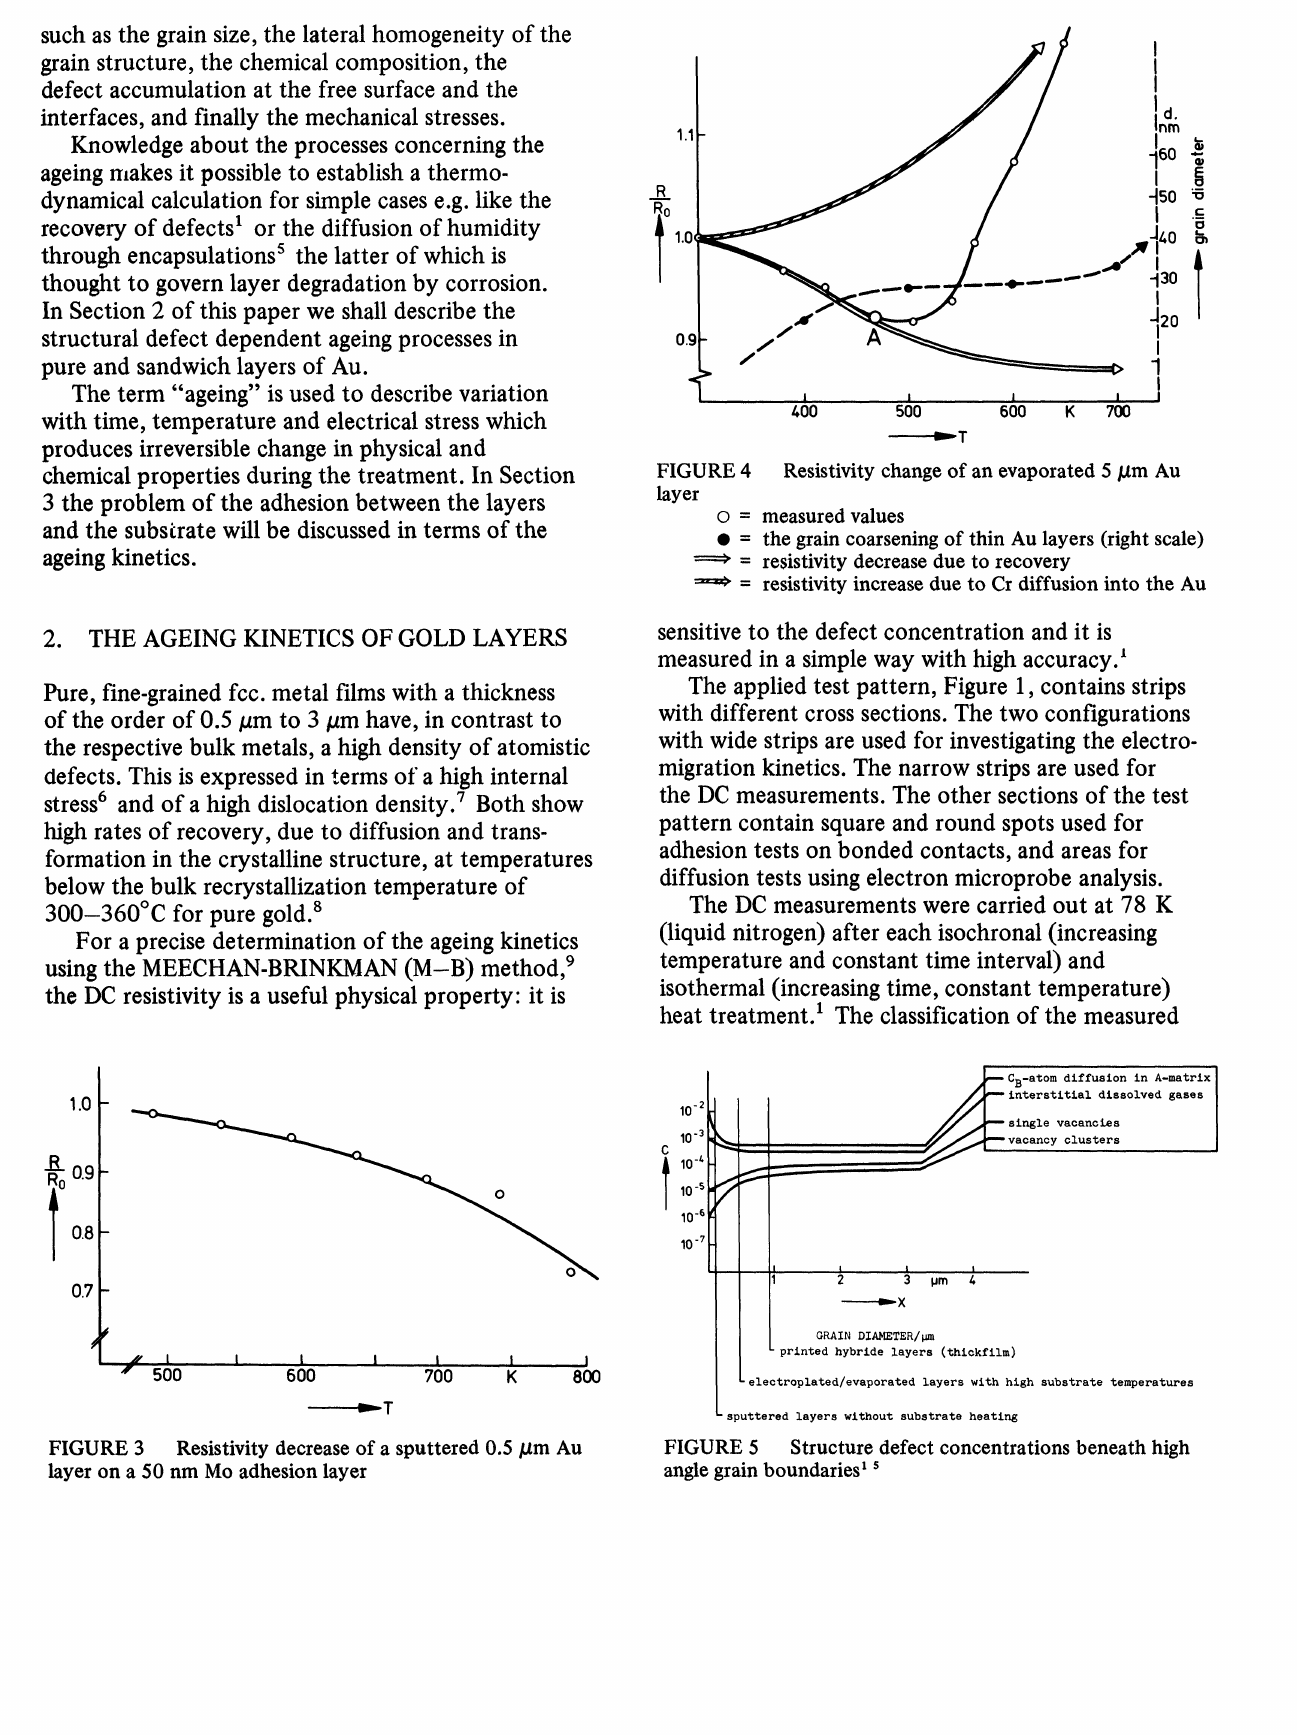
Resistivity decrease of a sputtered 0.5/am Au layer on a 50 nm Mo adhesion layer